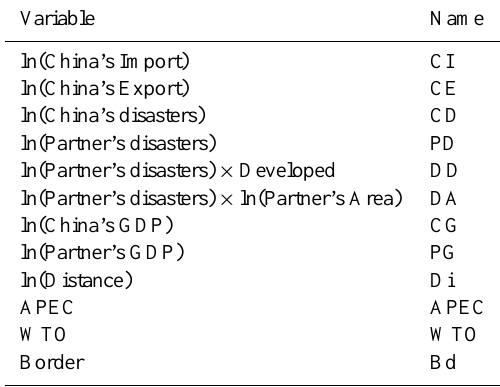
Table 1. Variable